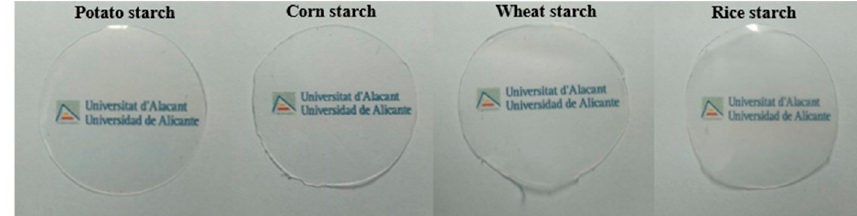
Figure 2. Visual aspect of films obtained from potato, corn, wheat, and rice starch.